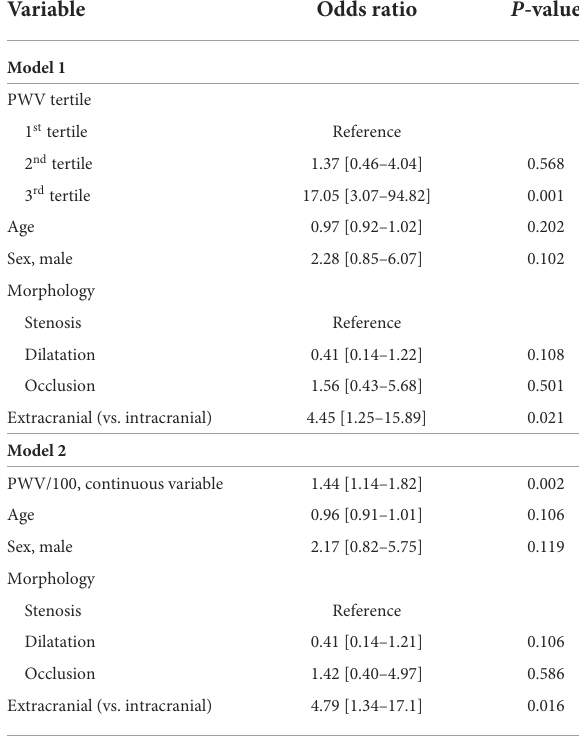
TABLE 4 Multivariable analysis to evaluate the association between pulse wave velocity values and ischemic stroke